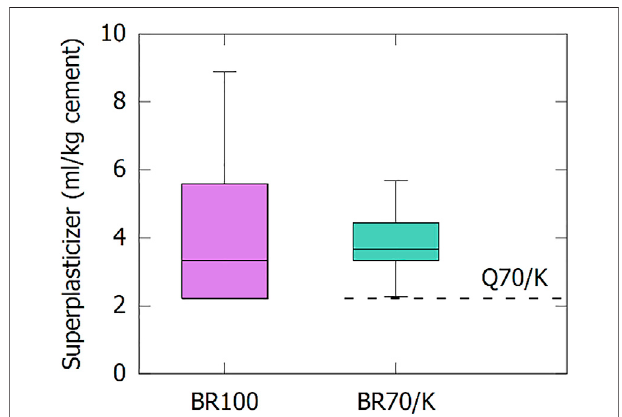
FIGURE 8 | Superplasticizer requirement of the mortars including (co-) calcined BR as SCM. The dashed line indicates the superplasticizer requirement of quartz co-calcined with 30 wt% of kaolinite.